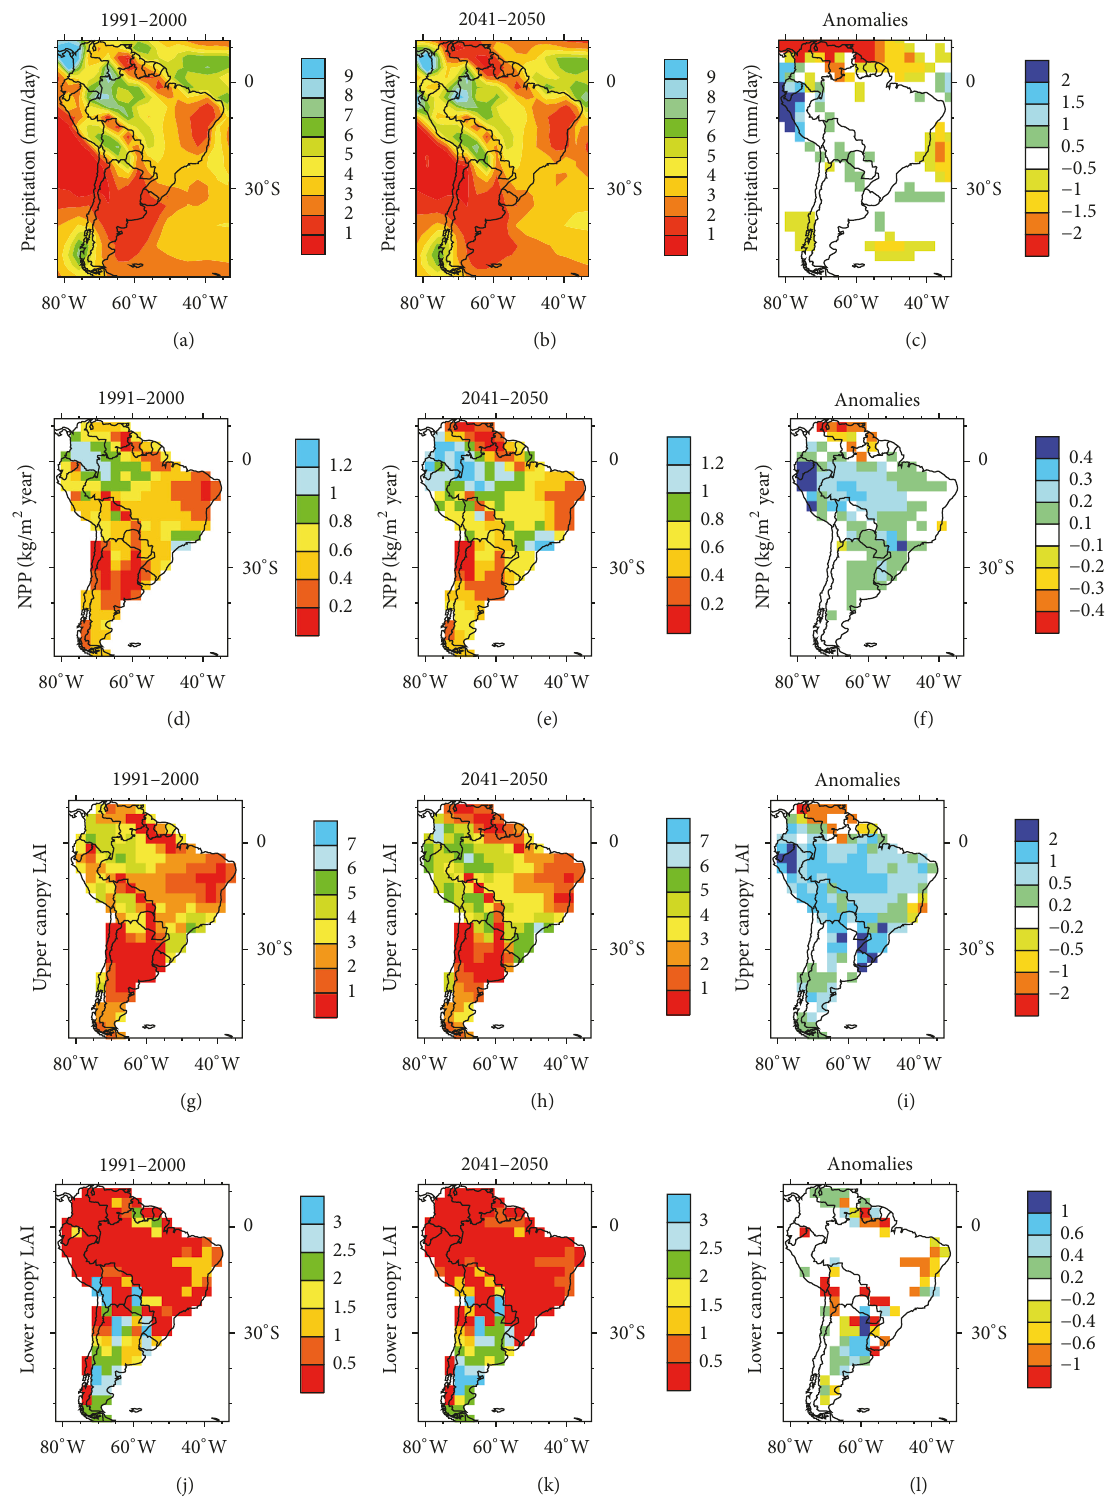
Figure 2: Decadal means of precipitation (mm/day) (a-b), NPP (kg C/m 2 year) (d-e), upper canopy LAI (m 2 /m 2 ) (g-h), and lower canopy LAI (m 2 /m 2 ) (j-k) in South America over present-day conditions (1991–2000) (a, d, g, j) and future scenario (2041–2050) (b, e, h, k) and anomalies (2041–2050; 1991–2000) (c, f, i,